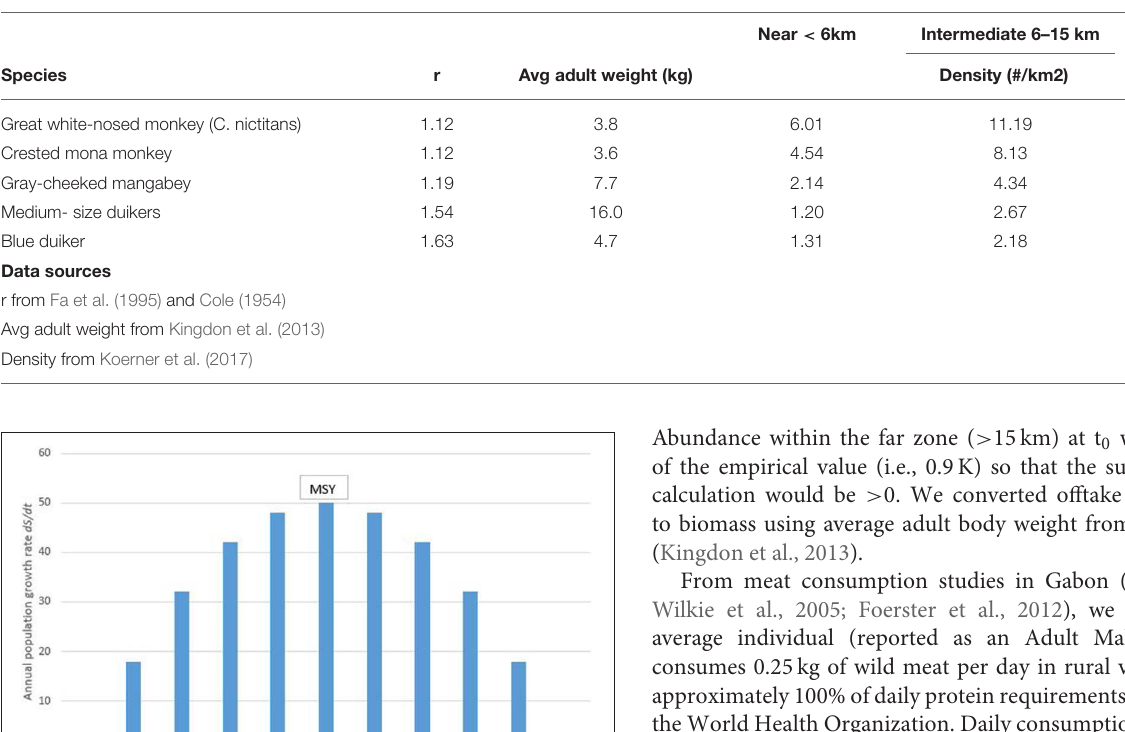
TABLE 1 | Intrinsic rate of increase, average adult body weight, and density of hunted primates and ungulates within the Makokou study area, Gabon.